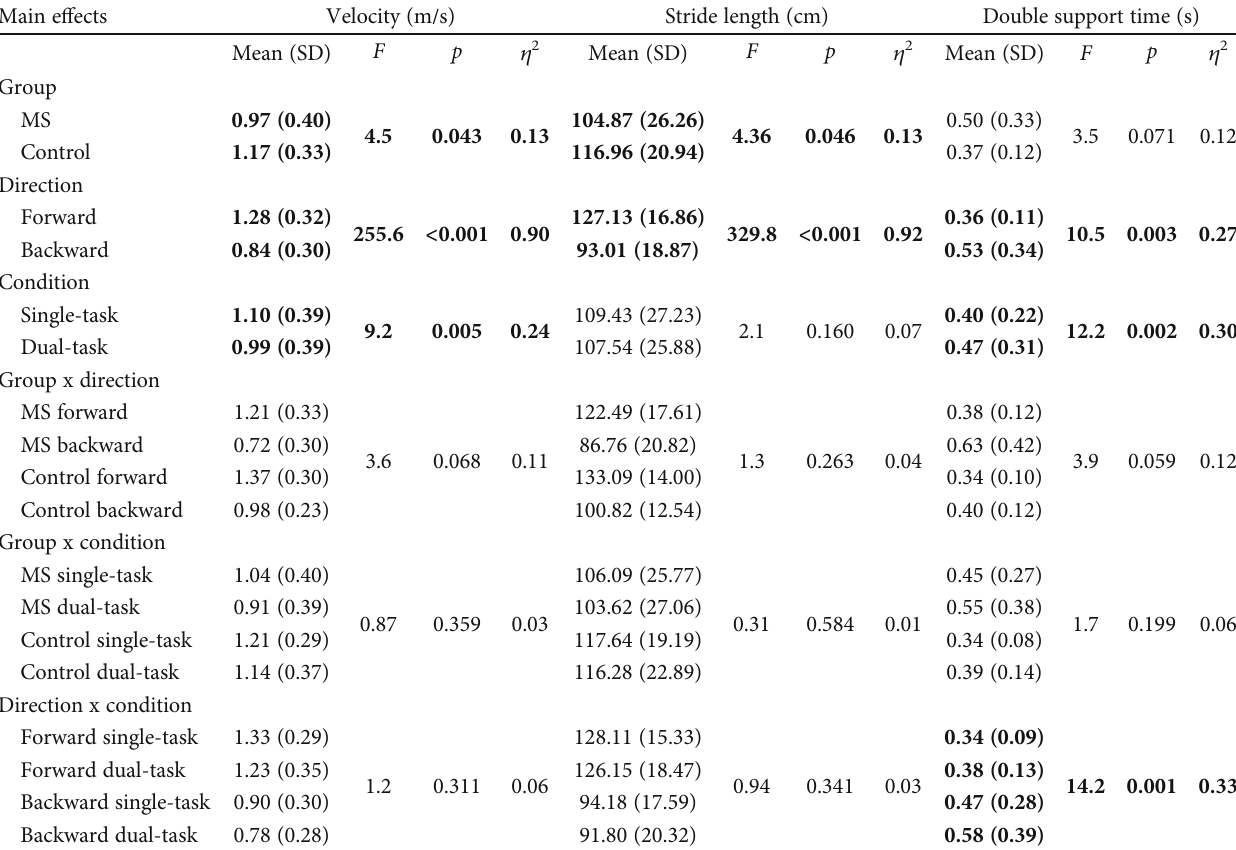
Table 1: Main e ff ects and interactions for spatiotemporal measures of